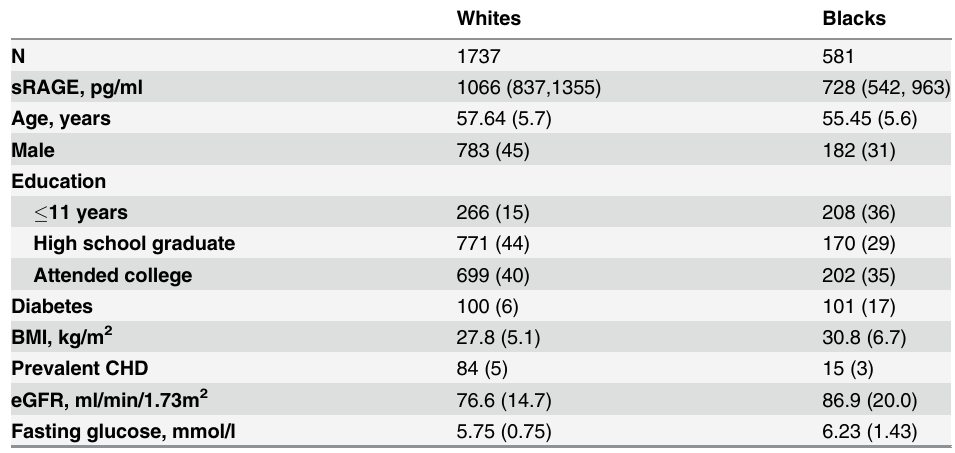
Table 1. Characteristics of black and white participants with sRAGE levels (N = 2,329). a, b, c, d